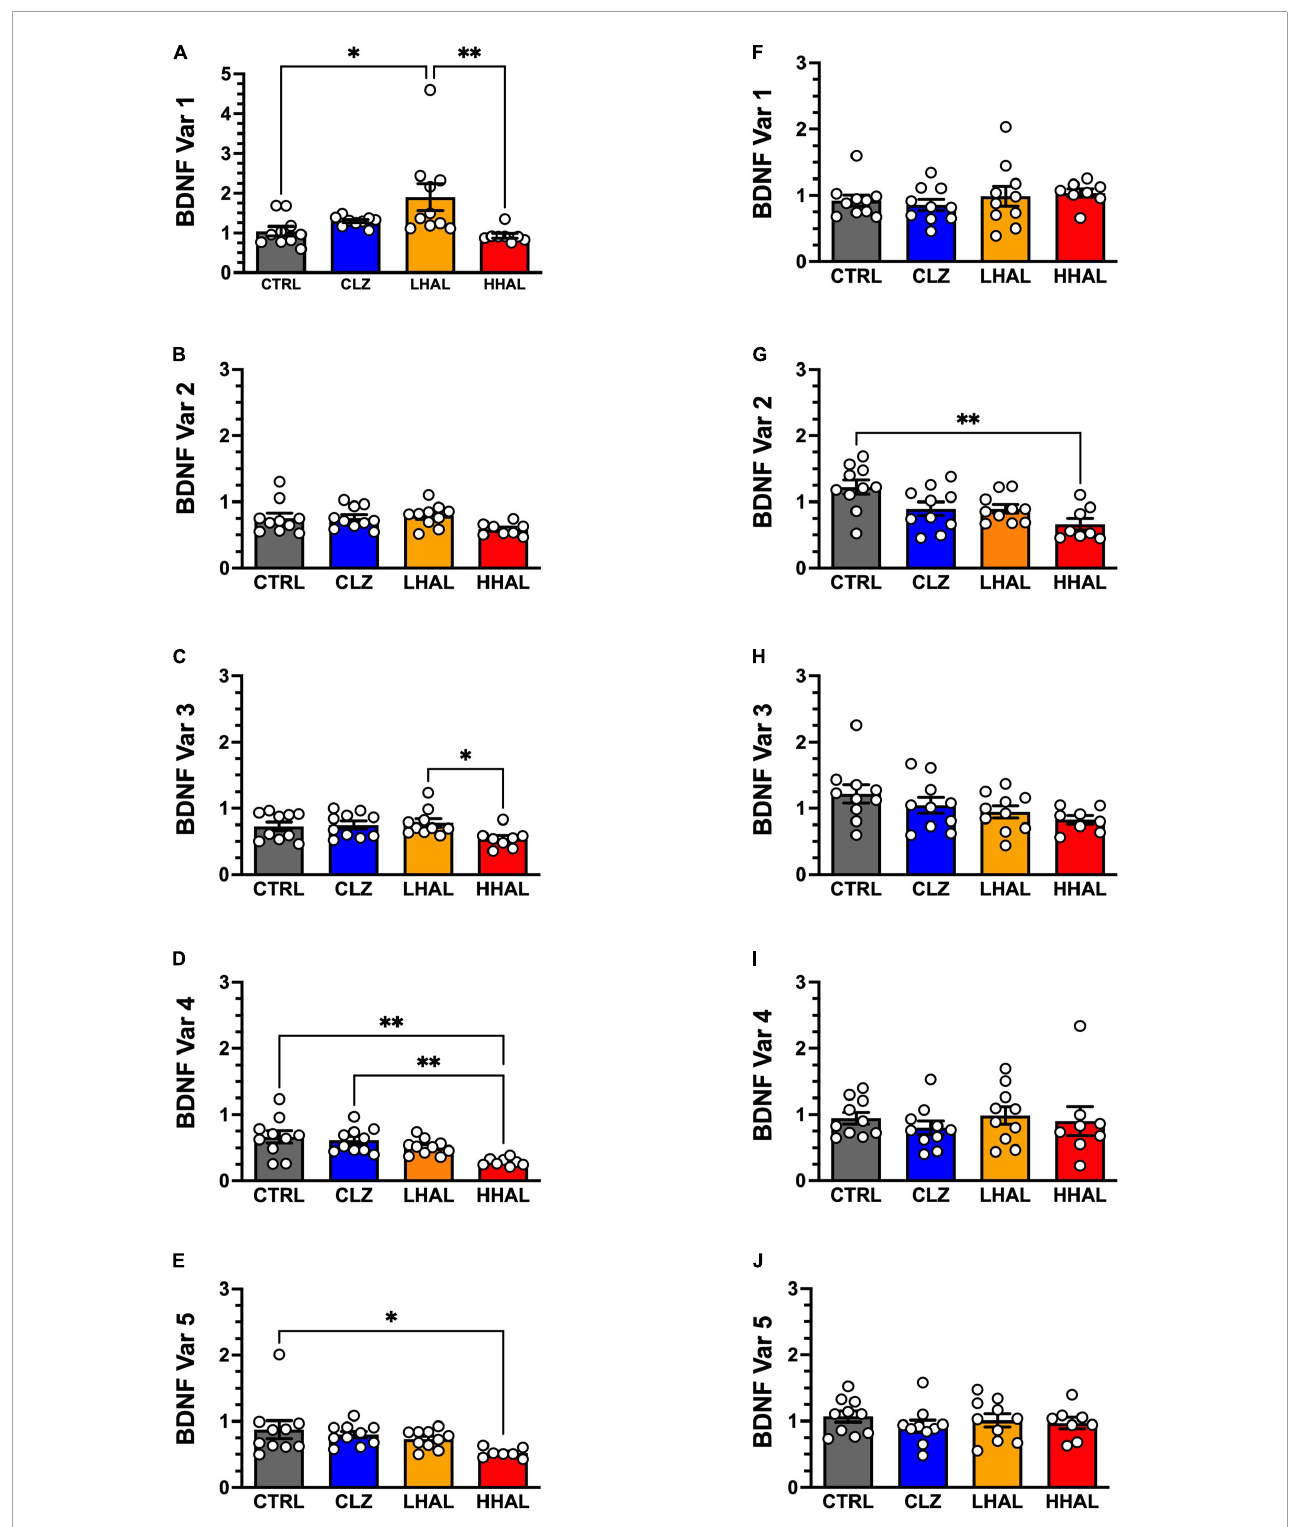
FIGURE2 BDNF variant mRNA levels in the DLPFC and EC of rhesus monkeys following 6-month antipsychotic administration regimen. BDNF variants 1–5 were assessed in the DLPFC and EC using qPCR. In the DLPFC (A–E) , significant differences between the groups were identified for BDNF variant 1 [ F ( 3 , 34 ) = 6.88, P = 0.0011], variant 4 [ F ( 3 , 37 ) = 6.635, P = 0.0012], and variant 5 [ F ( 3 , 35 ) = 5.5, P = 0.0037]. Tukey’s multiple comparison test revealed the followings differences: Variant 1: LHAL > CTRL ( P = 0.0163), ( P = 0.0094); Variant 4: CTRL > HHAL ( P = 0.0011), CLZ > HHAL ( P = 0.0052); Variant 5: CTRL > HHAL ( P = 0.0355). No significant difference among groups were detected for BDNF variants 2 and 3 in the DLPFC. For the EC (F–J) , a significant difference between the groups was identified for BDNF variant 2 [ F ( 3 , 34 ) = 5.805, P = 0.0026]. Tukey’s multiple comparison test revealed CTRL > HHAL ( P = 0.0014). No significant difference among groups was observed for the other BDNF variants in the EC. BDNF variant values are presented as bars which represent the mean ( ± S.E.M.) values following determination from relative standard curves. For each subject, BDNF variant expression values were calculated as quantitative mean value of the variant divided by the average of the quantitative mean values for the two reference genes for the respective regions. Bars represent the mean ± S.E.M. for the respective groups. Circles denote expression levels for individual subjects per group. ∗ p < 0.05, ∗∗ p <